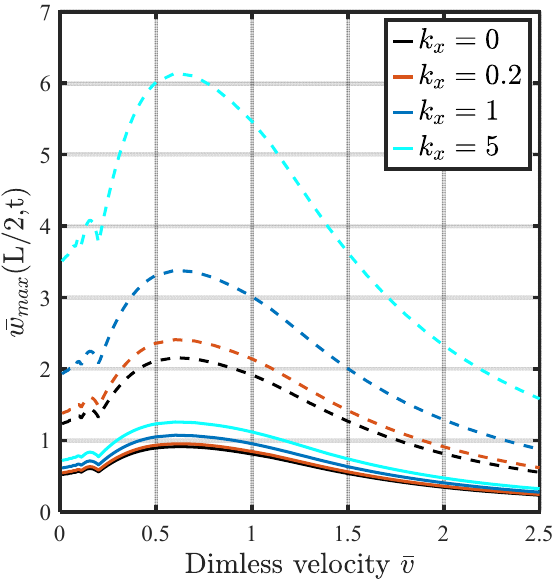
ature ‐ dependent (cid:4666)Δ(cid:1846) (cid:3404) 80, (cid:1838)(cid:1846)(cid:1844)(cid:4667) .